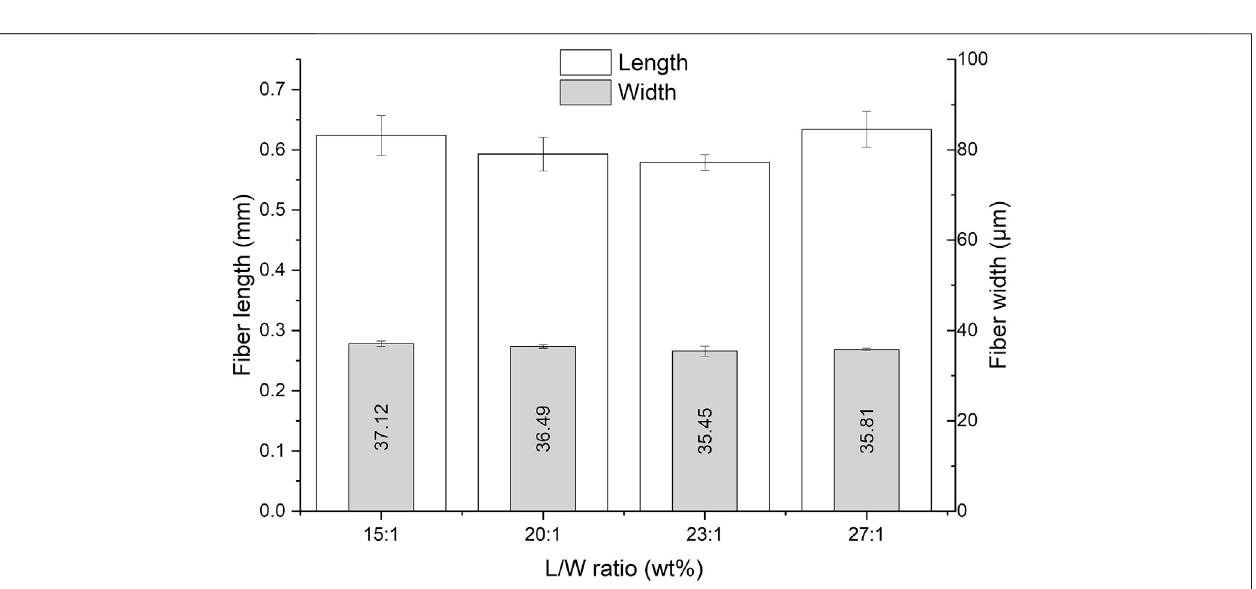
FIGURE 5 | The effect of the L/W on the fi ber length and width in the DES-cooking of Asplund (1 h of cooking at 130 ° C using the RE setup).